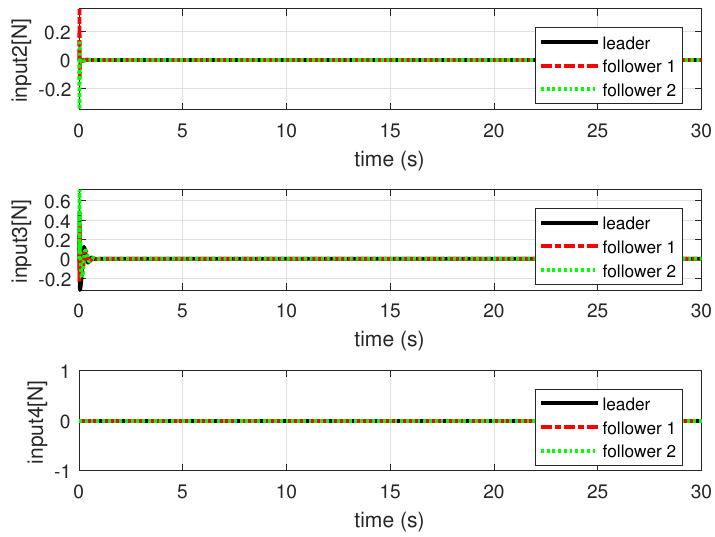
Figure 9. The control inputs for the attitude of the leader and follower